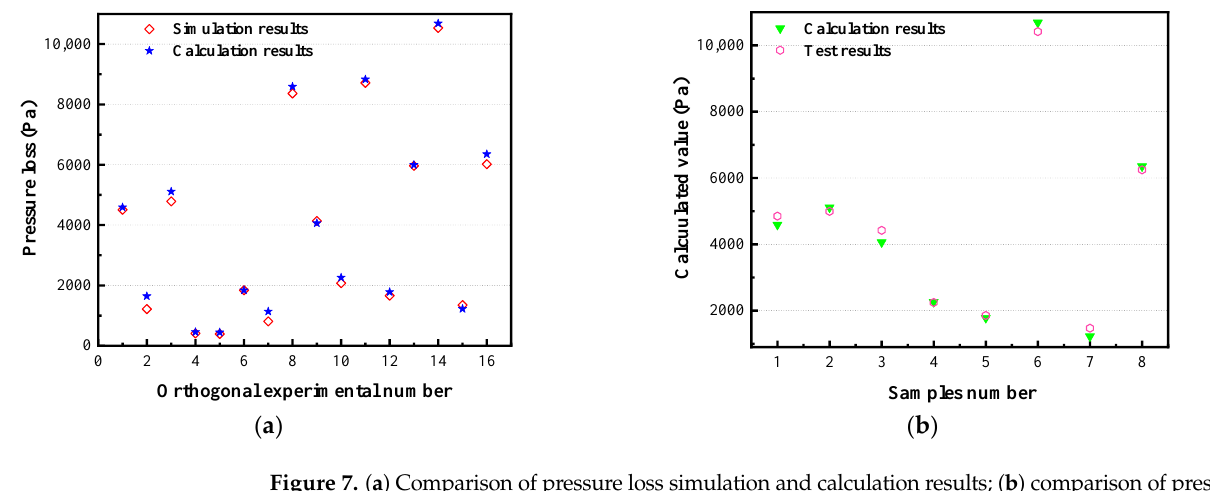
Table 7. Comparison between the test results of the flow channel samples and the calculation results of the mathematical model. Sample Number